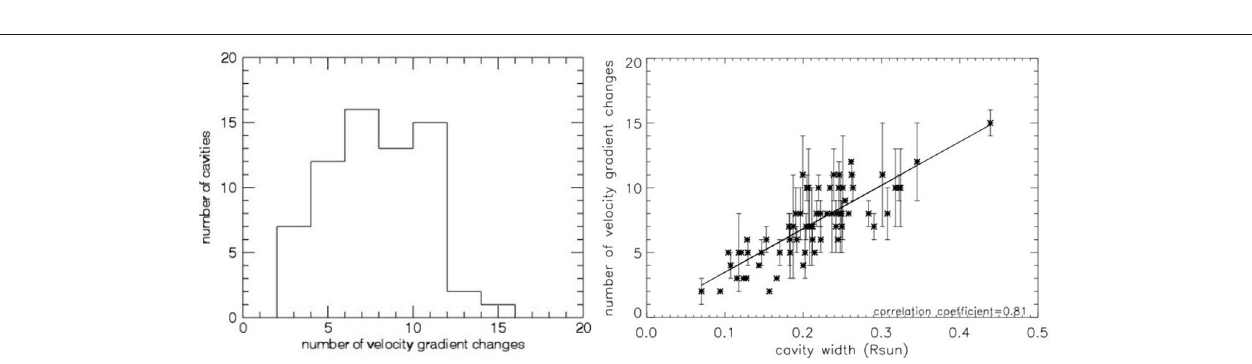
Frontiers in Astronomy and Space Sciences |